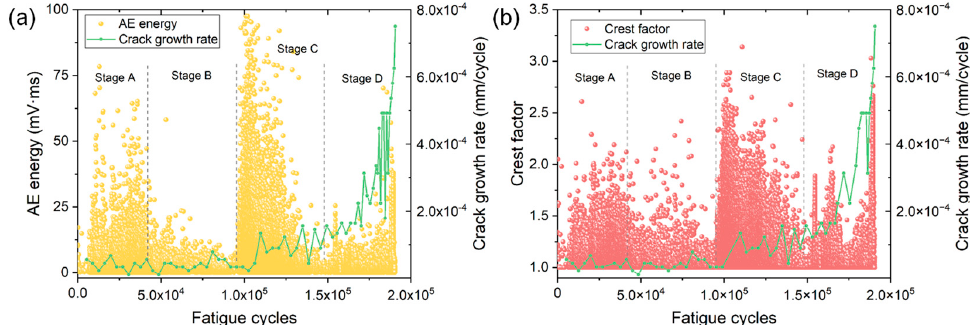
Figure 6. The variations of ( a ) AE energy and ( b ) crest factor versus fatigue cycles of specimen No. 2.